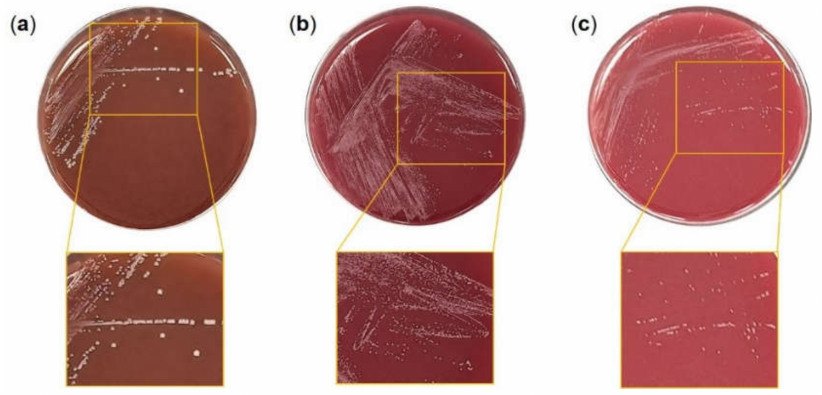
Figure 1. Hemolytic activity of ( a ) Lc. lactis MG5125, ( b ) B. bifidum MG731, and ( c ) B. lactis